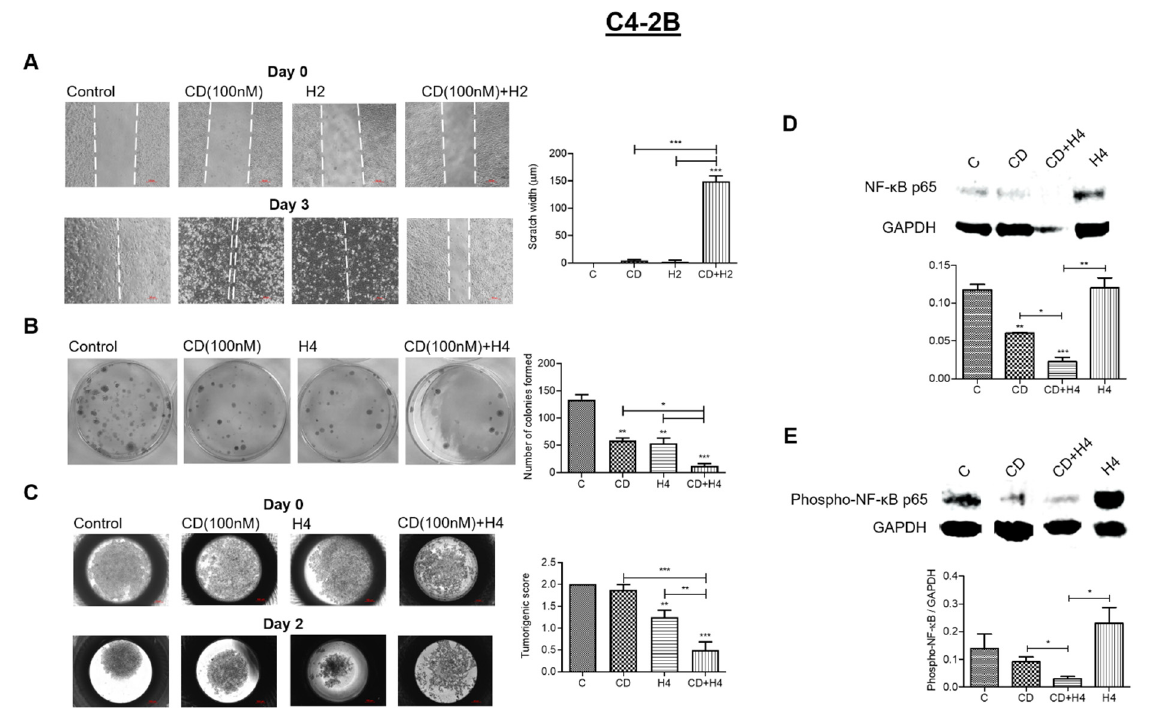
Figure 3. Effect of combination treatment on migration, colony formation, spheroid formation and both total and activated NF- κ B levels in C4-2B cells. Scratch-wound assays were carried out to measure the effect of low-dose FUS (H2), alone and in combination with CDDO-me (100 nM), at day 3 post treatment ( A ). Representative images of day 0 (top) and day 3 (bottom) wound width are shown on the left. Bar graph data on the right show wound width at day 3 ( n = 4), indicating a significant ( p < 0.001) suppression in migratory properties of C4-2B cells following combined treatment. In ( B ), CFU assays were carried out in C4-2B cells exposed to CDDO-me (100 nM) or FUS (H4), alone and in combination. Representative images of colonies are shown on the left, and bar graph data ( n =3) are shown on the right. Combined treatment resulted in a significant suppression of C4-2B colony-forming ability. ( C ) effect of combination treatment on spheroid formation by C4-2B cells at day 2 of the spheroid culture. Representative images of tightly or loosely packed spheroids are shown on the left, and bar graph data ( n = 8) are shown on the right. In ( D , E ), effects of combined treatment on both total and activated (phosphorylated) NF- κ B p65 protein levels are shown. Representative images of NF- κ B protein levels are shown in the top panel, and the loading control (GAPDH) is in the bottom panel. Bar graphs in both ( D , E ) are the data of three independent experiments ( n = 3). Significant changes from untreated controls or individual treatment groups are represented as p -values (* p < 0.05; ** p < 0.01; and *** p < 0.001).